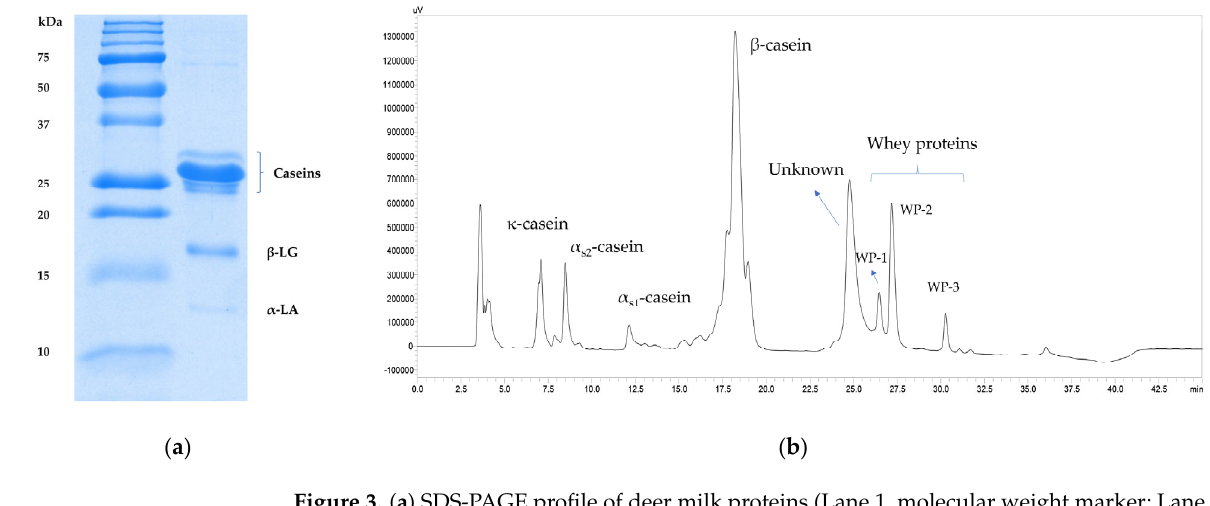
Figure 3. ( a ) SDS-PAGE profile of deer milk proteins (Lane 1, molecular weight marker; Lane 2, deer skim milk; β -LG, β -lactoglobulin; α -LA, α -lactalbumin). ( b ) HPLC profile of deer milk proteins (WP, whey